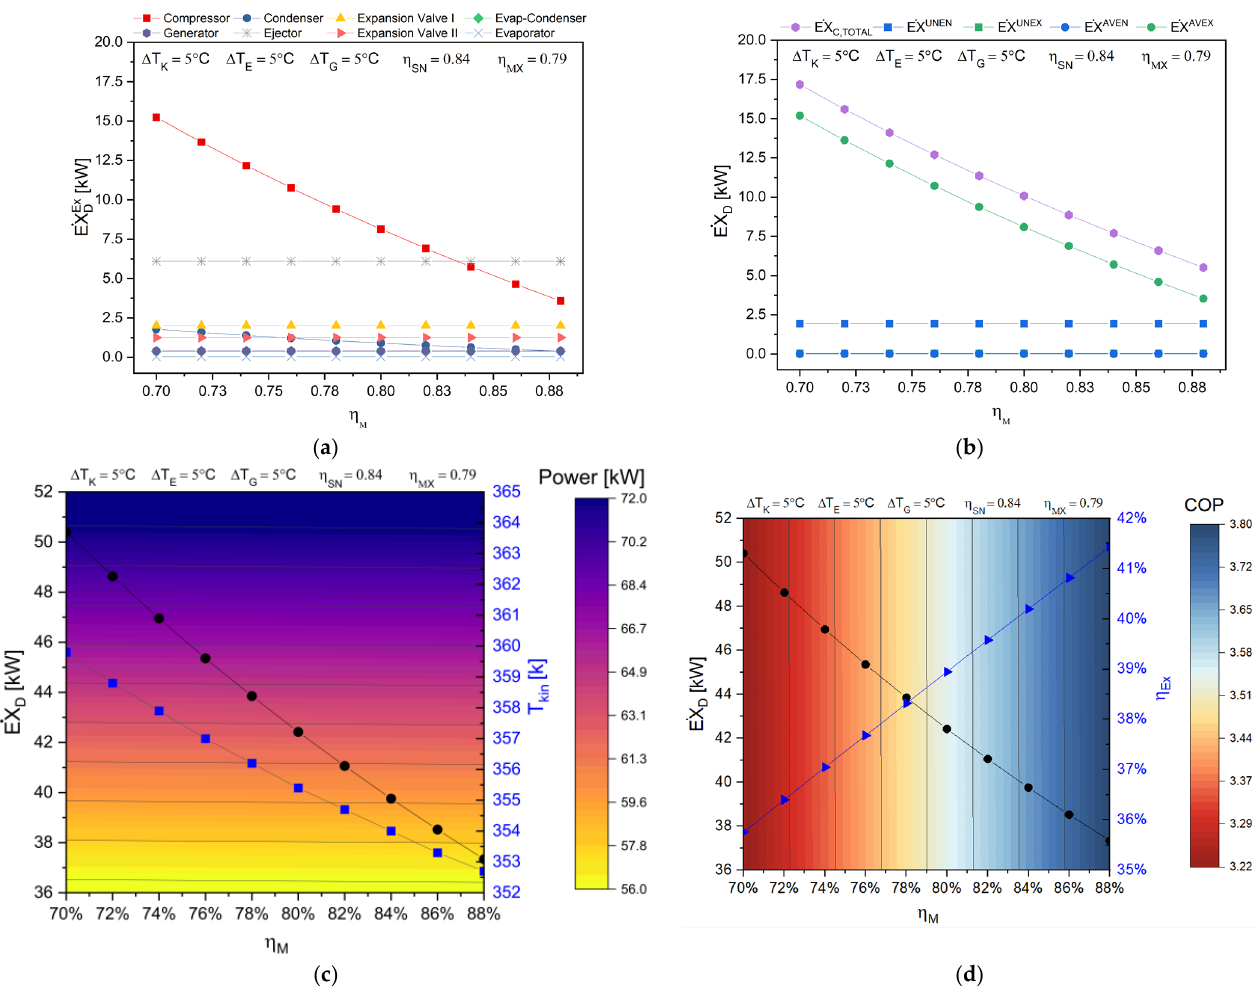
Figure 9. Compressor efficiency variation influence: ( a ) components exergy exogenous part, ( b ) compressor exergy destruction parts, ( c ) consumption power, and ( d ) system COP-exergy efficiency.